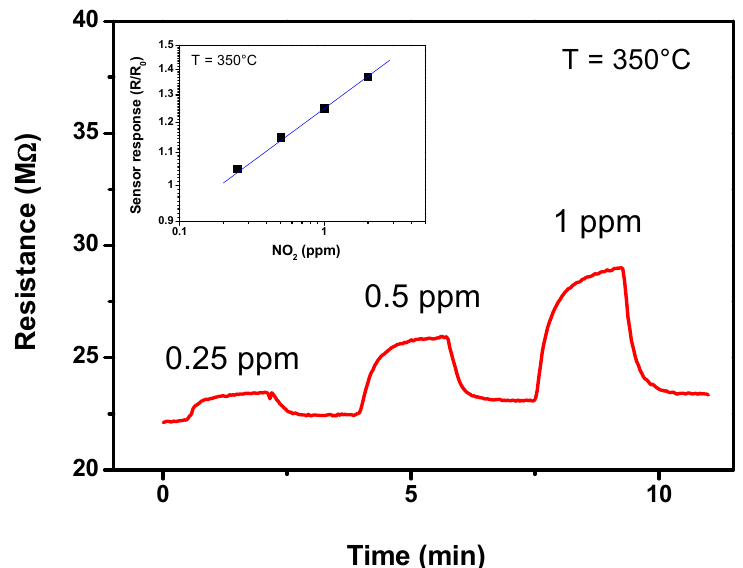
Figure 8. Transient responses of the nanofibers (NFs) based sensor tested to different NO concentrations in air at the operating temperature of 350 °C. In the inset is shown the calibration